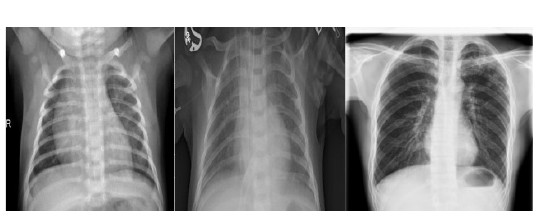
Fig. 1. X-ray images of Normal, Pneumonia and Tuberculosis.